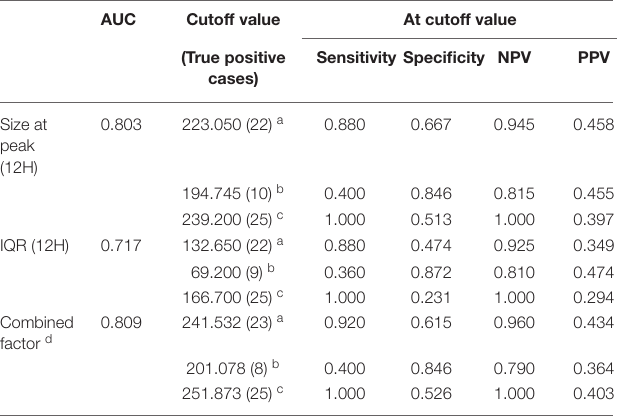
TABLE 6 | Receiver operating characteristic